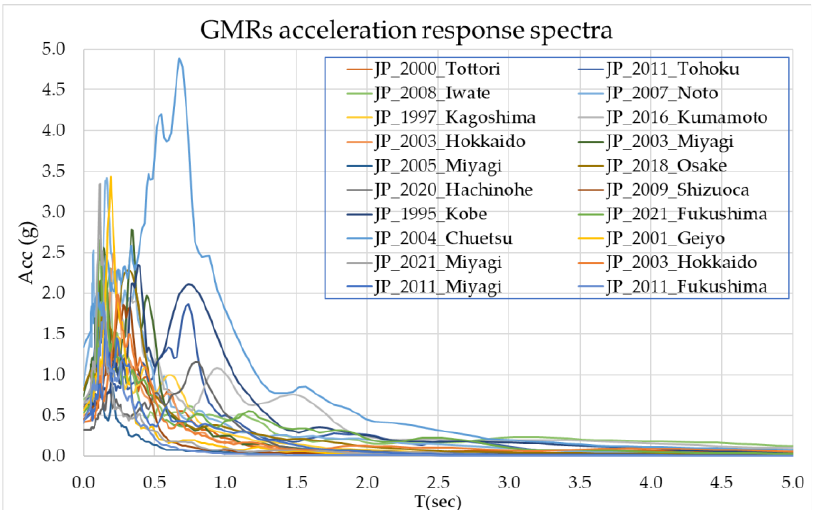
Figure 4. GMR acceleration response spectra (5% damping).